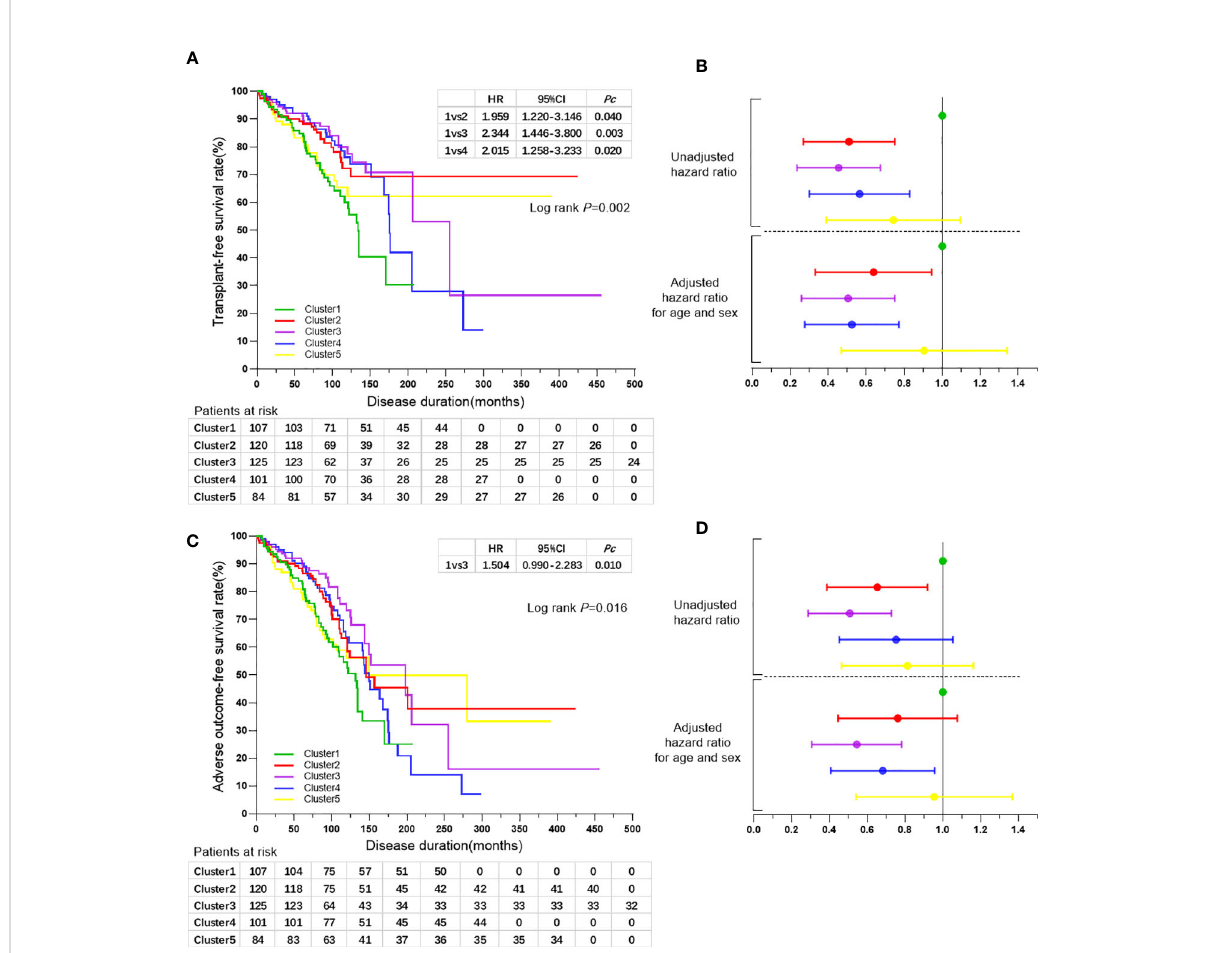
FIGURE 3 (A) Kaplan-Meier survival curves for the comparisons of transplant-free survival rates among the fi ve clusters of patients with PBC. (B) Forest plot showing hazard ratios of liver-related death or liver transplantation rates and 95% con fi dence intervals for the fi ve clusters of patients with PBC. Black line perpendicular to the horizontal axis shows the hazard ratio for the reference group of cluster 1. The horizontal broken line indicates the diving line for hazard ratios of liver-related death or liver transplantation rates before and after adjusted for age and sex. Colors represent the different clusters as indicated in (A, C) Kaplan-Meier survival curves for the comparisons of adverse outcome-free survival rates among the fi ve clusters of patients with PBC. (D) Forest plot showing hazard ratios of adverse outcome rates and 95% con fi dence intervals for the fi ve clusters of patients with PBC. Black line perpendicular to the horizontal axis shows the hazard ratio for the reference group of cluster 1. The horizontal broken line indicates the diving line for hazard ratios of adverse outcome rates before and after adjusted for age and sex. Colors represent the different clusters as indicated in (A)